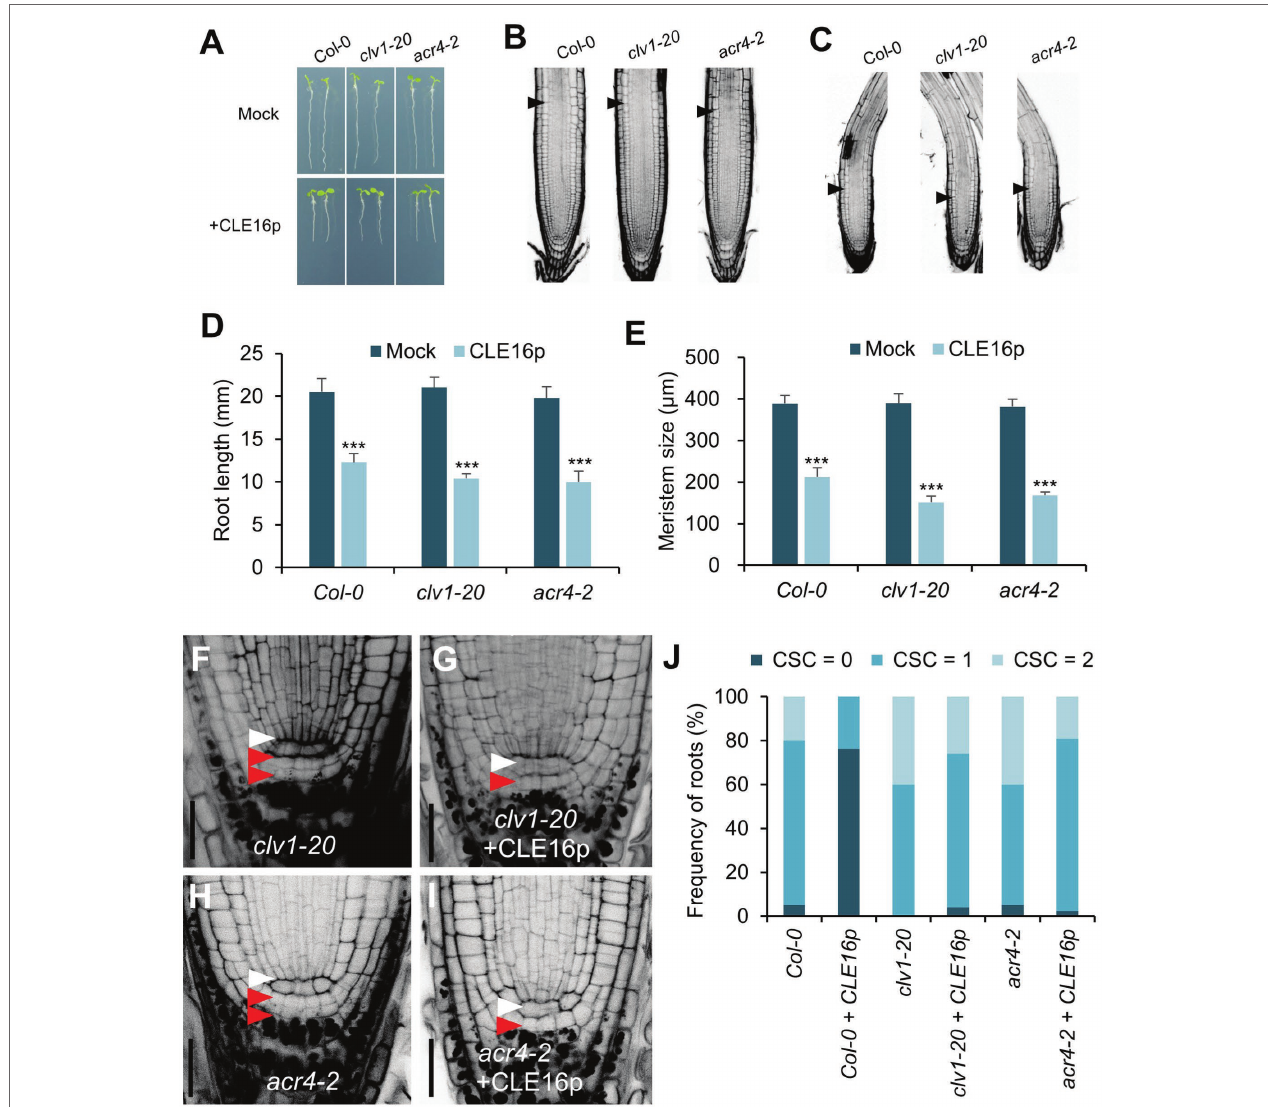
FIGURE 4 | CLV1-ACR4 complex acts in the CLE16 signaling pathway to promote columella cell differentiation. (A) Seedlings at 5 dpg were treated without (top row) or with 1 μ M CLE16p (bottom row). (B,C) Confocal images of roots stained with PI after mock treatment (B) or CLE16p treatment (C) . Black arrowheads indicate the junction between meristematic and elongation zones. (D,E) Quantification of root length (D) and meristem size (E) of the genotypes shown in (A) and (B,C) , respectively. Error bars represent SD. n > 20 for each genotype. Student’s t -test, * p < 0.05, ** p < 0.01, and *** p < 0.001. (F–I) Representative confocal images of the root tips stained with mPS-PI after mock treatment (F,H) or CLE16 treatments (G,I) . White and red arrowheads indicate QC cells and CSCs, respectively. (J) Quantification of CSC differentiation of the indicated genotypes. n > 50 for each genotype. Roots were grown on agar medium supplemented with or without 1 μ M CLE16p for 5 days (A–J)